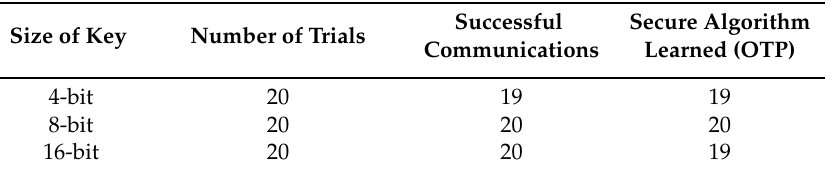
Table 3. 20 networks were learned CPA-ANC and tested using Algorithm 1 for each key size. Most of the trials were successful since Alice and Bob were able to communicate without errors. Most of the successful networks learned the OTP, which is a secure cryptosystem.